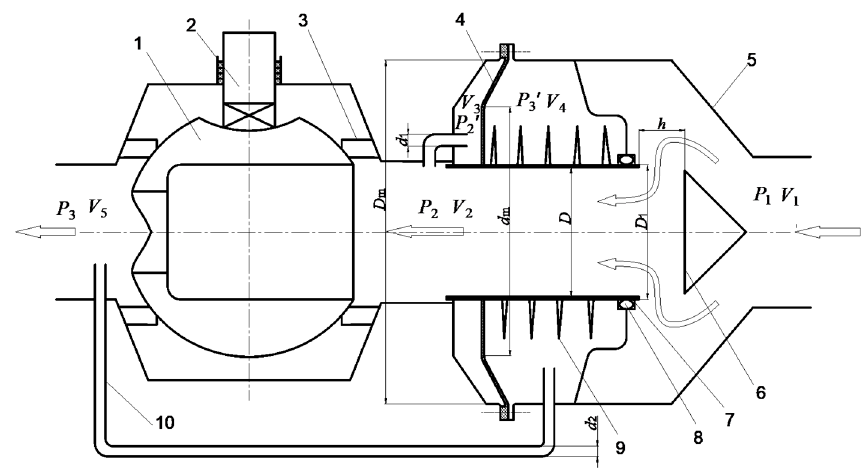
Figure 2. Schematic diagram of the structure of the dynamic flow balancing valve. 1. V-shaped ball core; 2. valve stem; 3. ball valve seat; 4. diaphragm; 5. valve body; 6. regulator valve seat; 7. pressure regulator valve core; 8. O-ring; 9. spring; 10. pressure guiding hole.